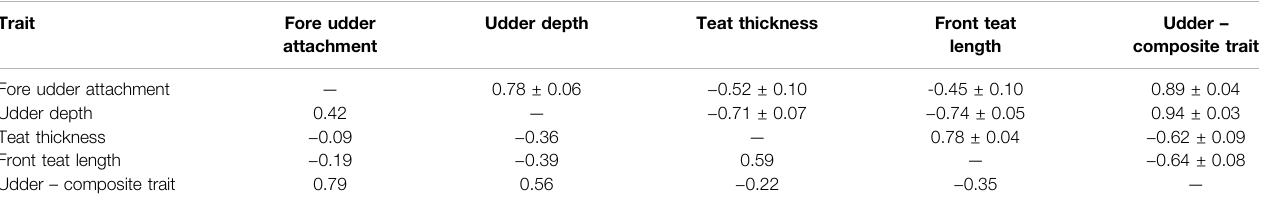
TABLE 8 | Estimated genetic correlations ± standard errors (above diagonal) and phenotypic correlations (bellow diagonal) for scored udder traits and the composite trait udder from Group 6.